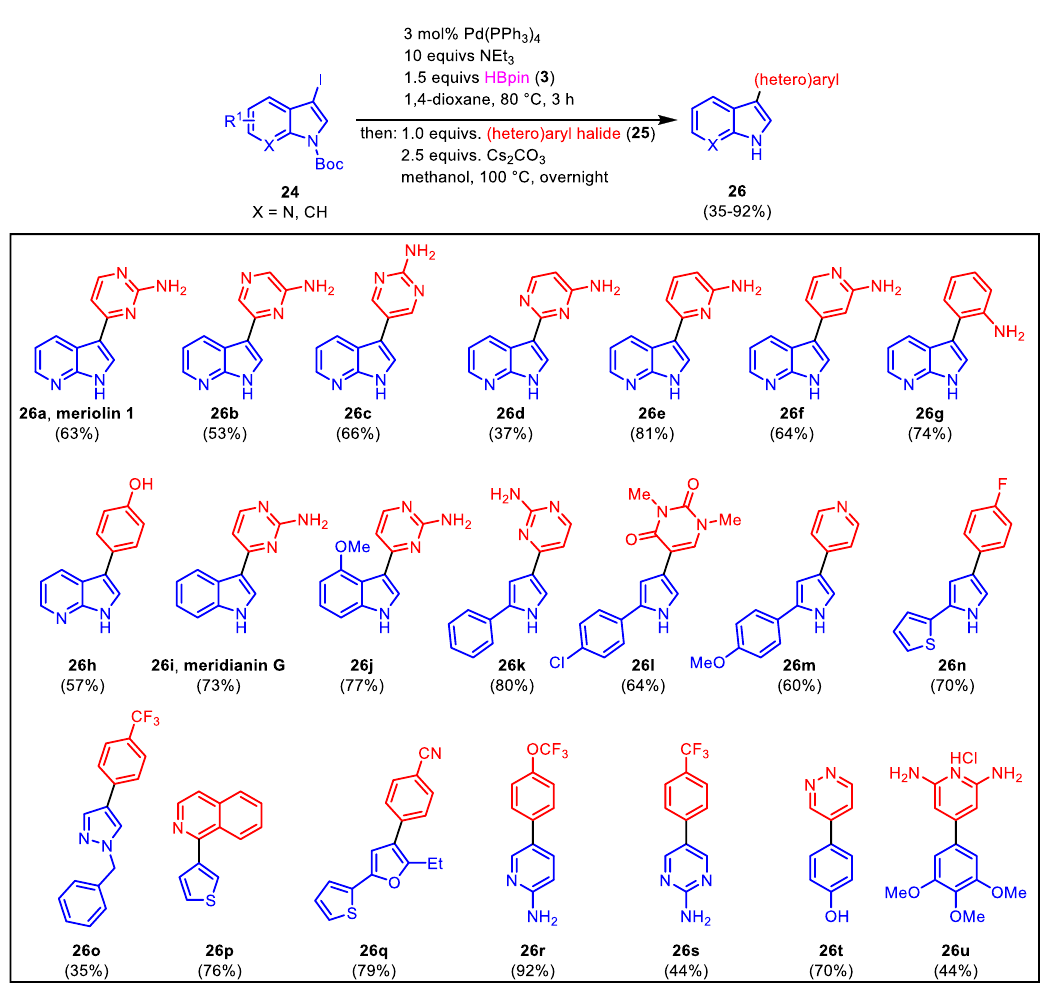
Figure 15. General one-pot MBSC protocol for the coupling of (7-aza)indoles and 5-membered aryl iodides 24 by Merkul et al. [31].